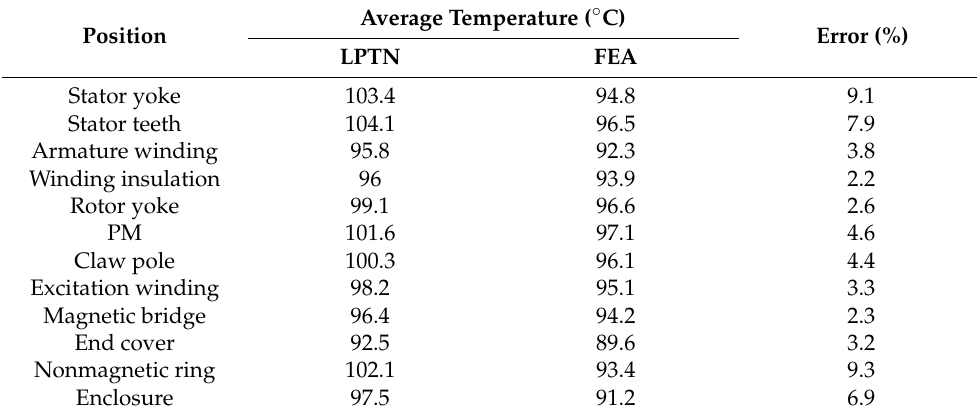
Table 3. Comparison of LPTN and FEA results.